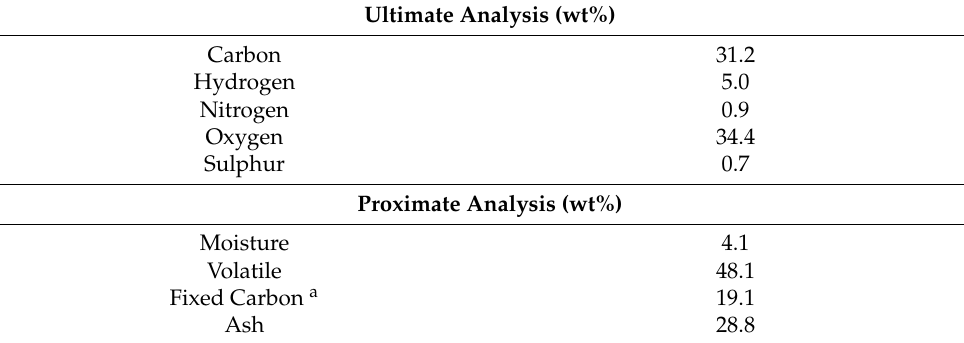
Table 2. Ultimate and proximate analysis of chicken